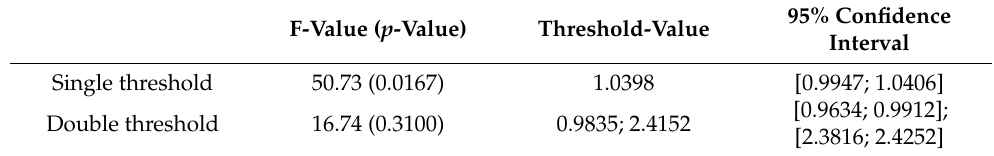
Table 6. Threshold effect test results.